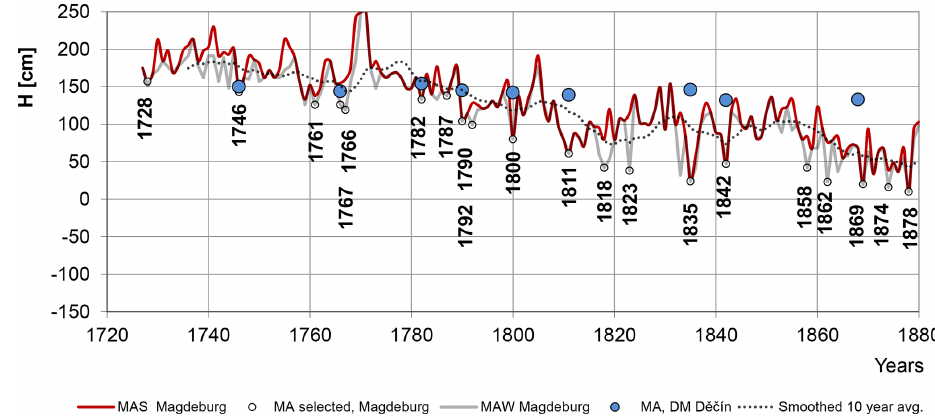
Figure 6. Verification of marks in the period of 1727–1800 according to the annual (MAW, grey line) and summer (MAS, red line) minima of the Magdeburg 1727–1800 series with annual minima identified (and derived) from the marks on the HS3 hunger stone in Dˇeˇcín (MA, blue